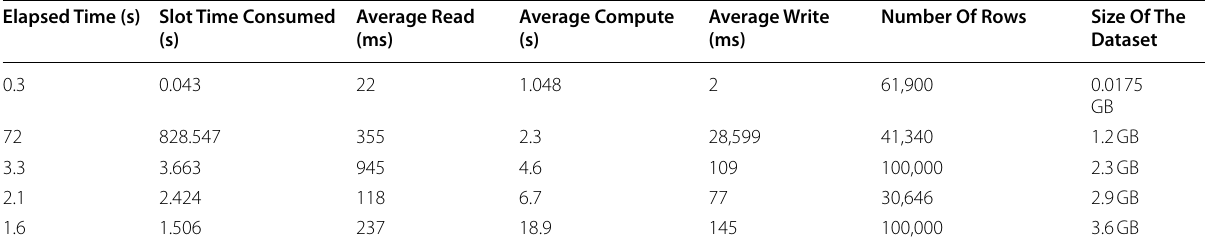
Table 1 BigQuery performance tests Elapsed Time (s) Slot Time Consumed (s)